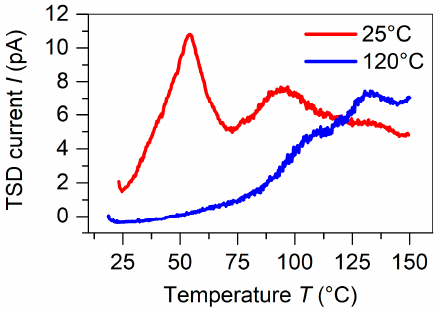
Figure 5. Open-circuit TSDC spectra measured for alternating FEP/TPU/FEP and FEP/air/FEP devices with a width ratio of 1 charged in a corona triode utilizing V C = − 10.0 kV and V G = − 4.0 kV and two different temperatures as indicated.